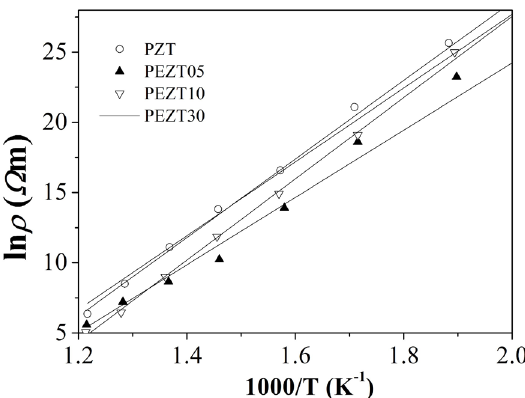
Figure 7. Plots of lnρ vs . 1000/ T for the PZT52/48 and PEZTs´ ceramics above T at 1 MHz. c